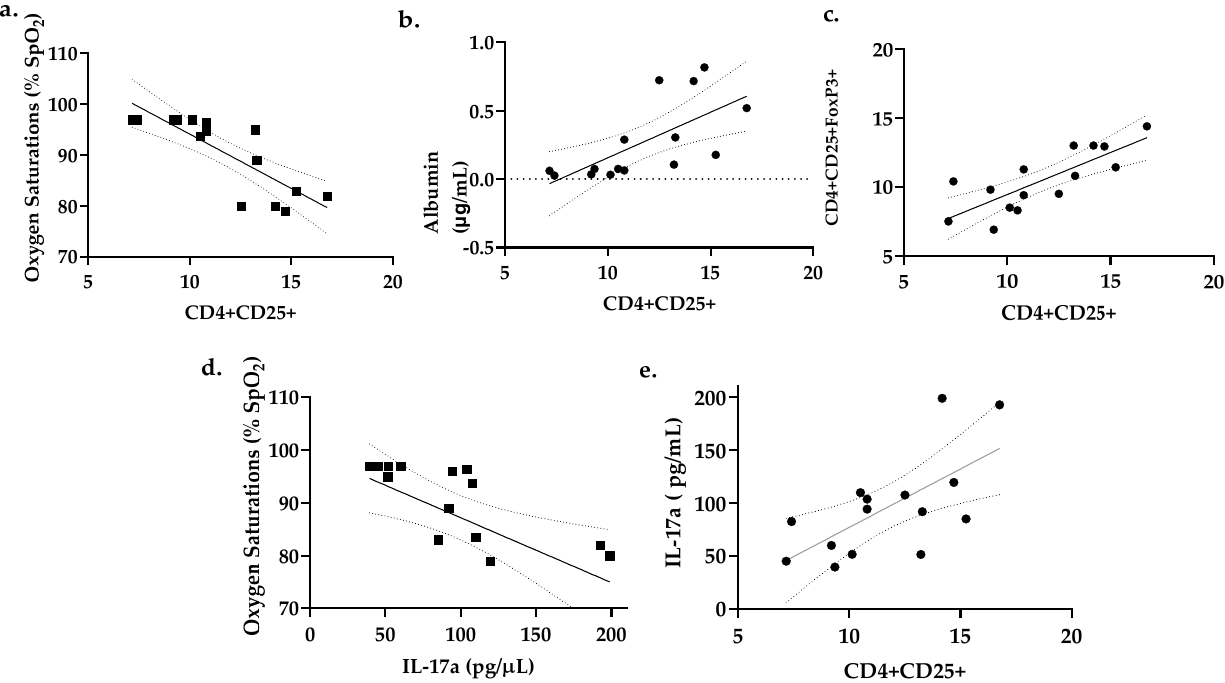
Figure 6. Pearson correlations between oxygen saturations, bronchoalveolar lavage fluid (BALF) albumin, BALF IL17a expression, and percent (%) total lung CD4 + CD25 + T cells after diacetyl inhalation exposures. ( a ) Oxygen saturations correlated inversely with % lung CD4 + CD25 + T cells ( r = − 0.7320, p < 0.001). ( b ) BALF albumin correlated directly with percent lung CD4 + CD25 + T cells. ( r = 0.8942, p < 0.01). ( c ) Foxp3 positive T cells correlated directly with CD4 + CD25 + T cells. ( r = 0.796, p = 0.0005) ( d ) Day 19 oxygen saturations correlated inversely with BALF IL-17a concentration. ( r = 0.5315; p < 0.01). ( e ) BALF IL-17a correlated directly with percent lung CD4 + CD25 + T cells ( r = 0.6828; p = 0.0001 ) .